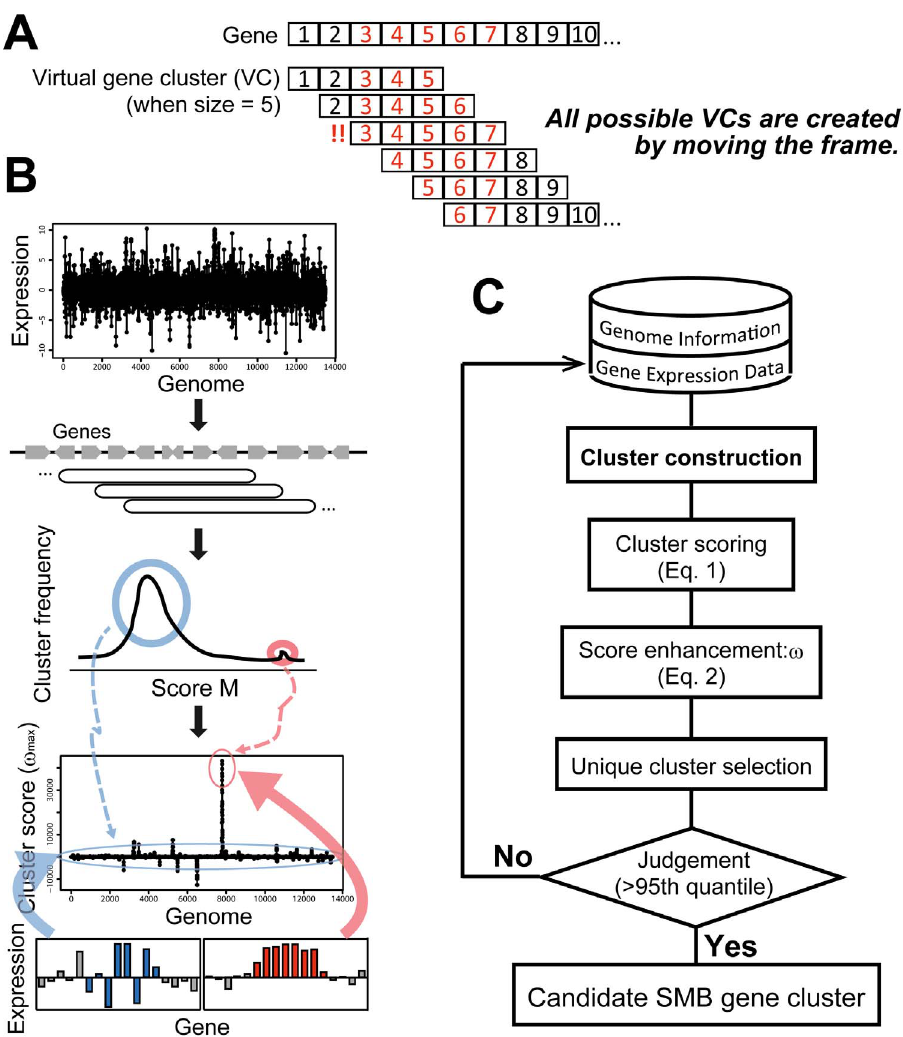
Figure 1. Principle of the MIDDAS-M algorithm. (A) Virtual cluster (VC) generation for SMB gene cluster detection. Gene clusters on a genome are evaluated comprehensively by a moving window with a specific cluster size; the cluster size can be changed from 3 to 30 or another appropriate size. (B) Schematic representation of MIDDAS-M. Candidate SMB gene clusters show large deviations from the standard deviation after summing the induction ratios of member genes and statistical enhancement. (C) Flow chart of the MIDDAS-M